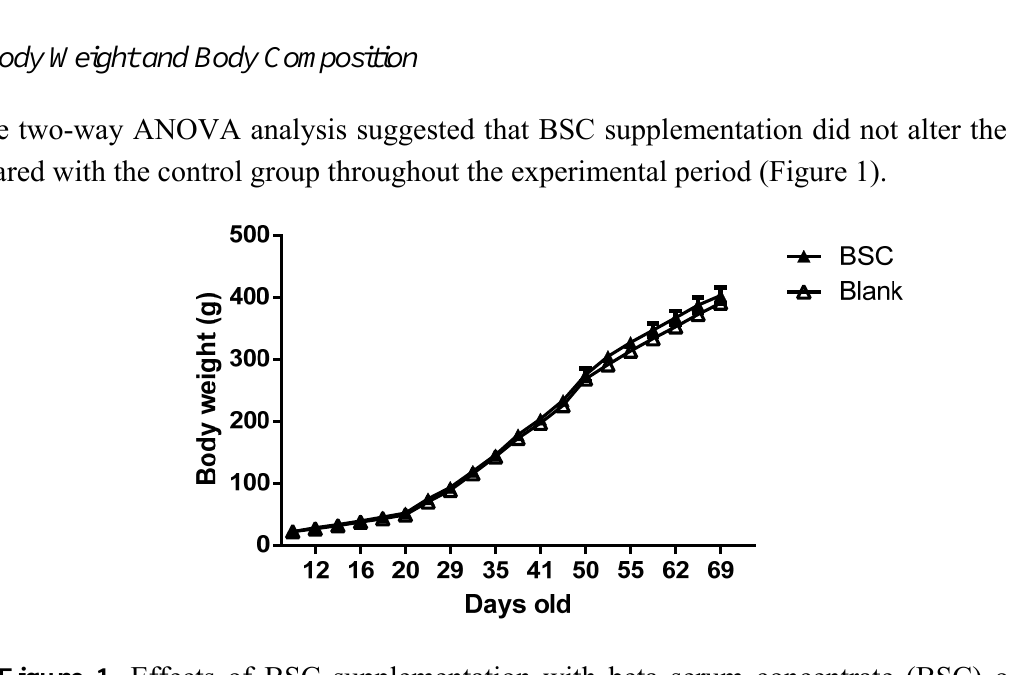
Figure 1. Effects of BSC supplementation with beta serum concentrate (BSC) on body weight;.two-way ANOVA analysis. The data are presented as mean ± SEM, n = 16. Two-tailed t -tests did not suggest any differences between the groups in the ratio of lean/fat mass percentage of body fat, the average bone mineral density and the body length (Table